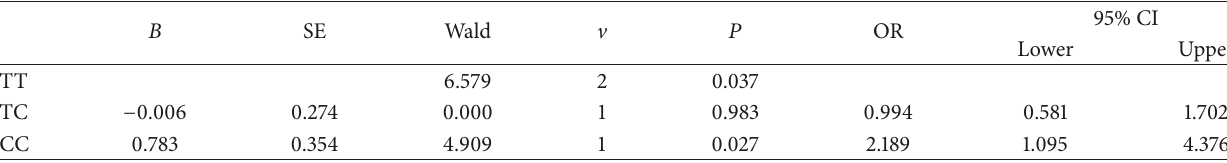
Table3:Multiplefactorslogisticregressionanalysisofthers1014290genotypein SLC2A9 ontheriskofPD ∗ .IndividualswiththeCCgenotype in SLC2A9 had a higher risk of PD than individuals with the TT or TC genotype.